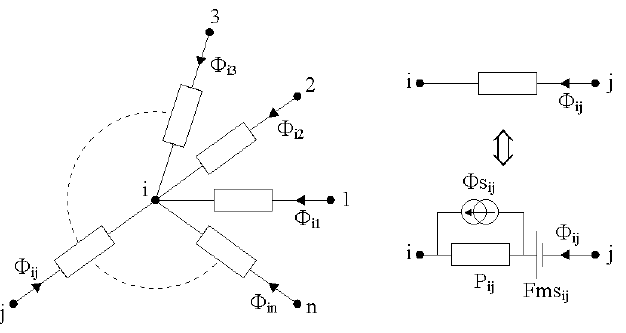
Figure 25. Mesh equation setting for the i th node.